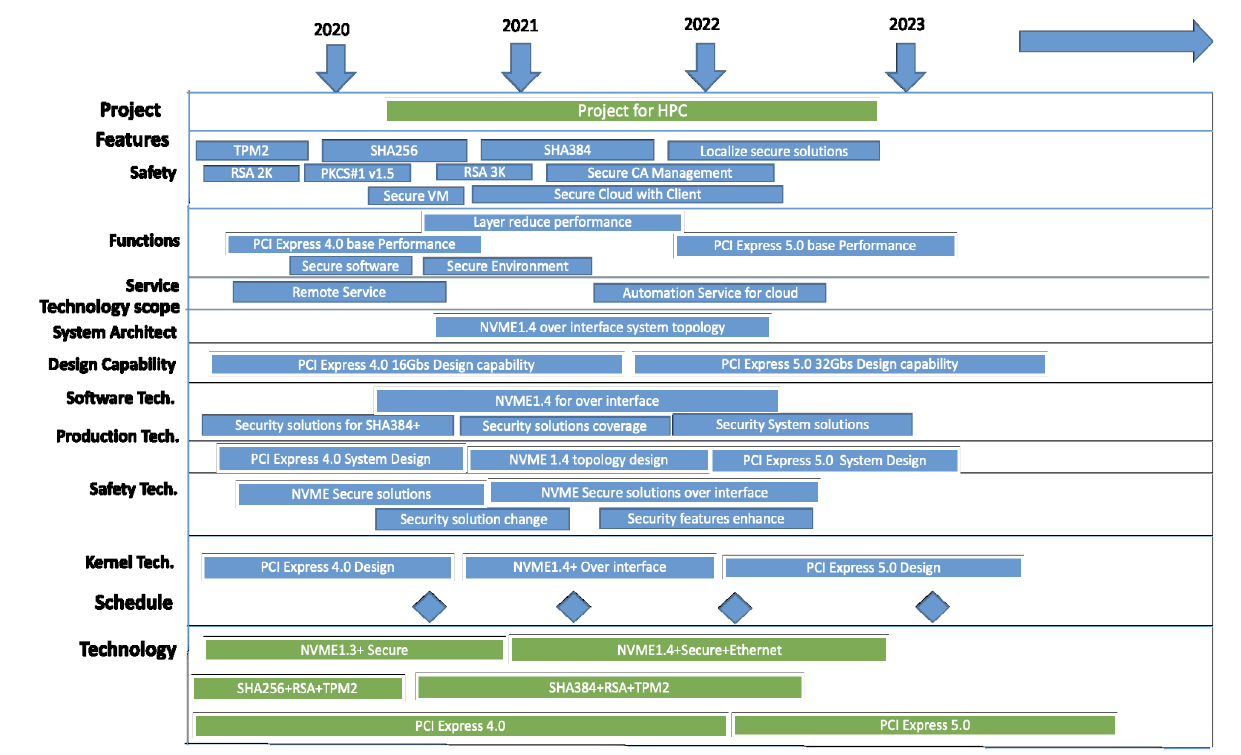
Figure 20. Technology strategy roadmap for cloud